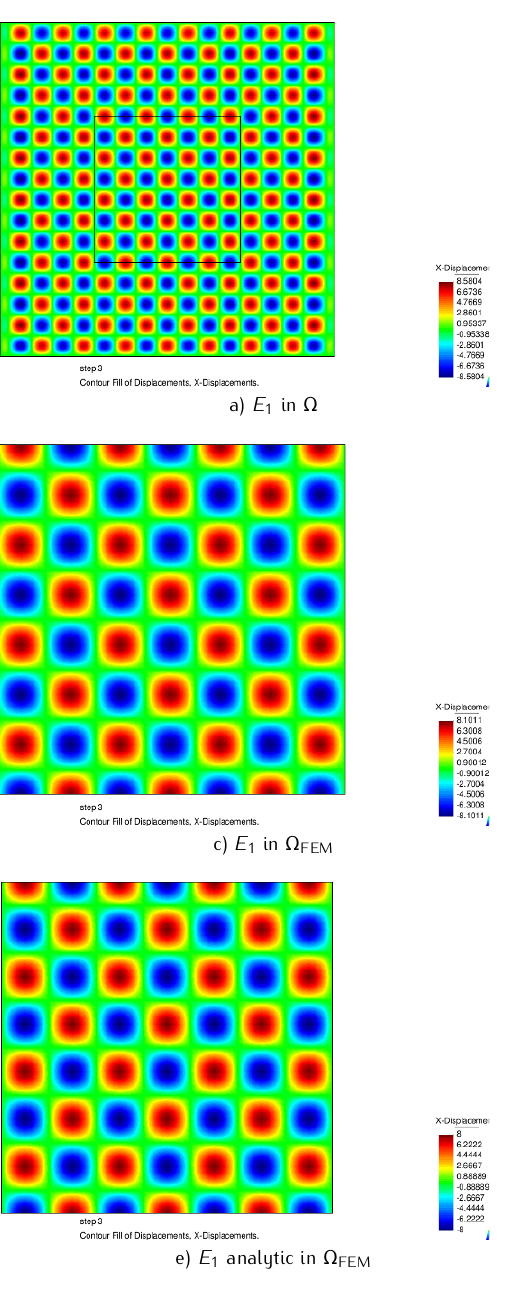
( E 1 ,E 2 ) versus the computed solution ( E 1 h ,E 2 h ) in the domain decomposition FEM/FDM at in Ω ; in c) and d) components ( E ,E 1 h 2 h ) , and in e) and f) components ( E of the analytic solution in Ω ,E FEM 1 2 ) FEM